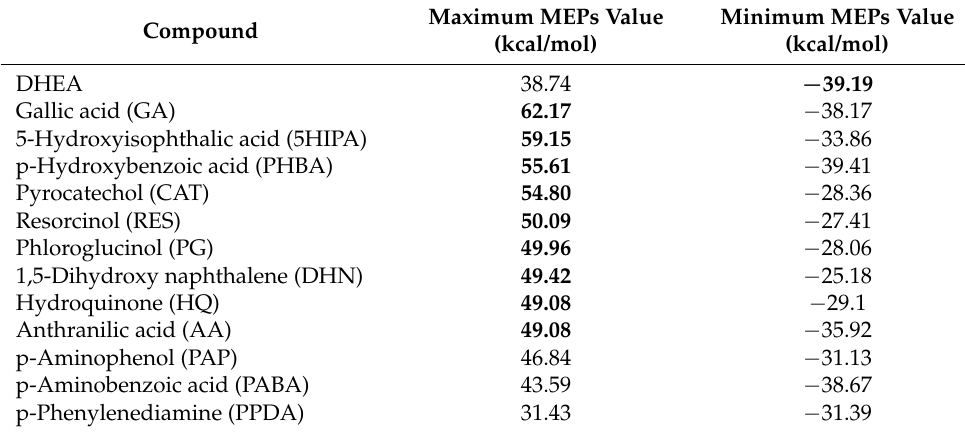
Figure 1. MEPs mapped onto 0.001 a.u. electron density isosurface of DHEA and twelve coformers. The electrostatic potential extreme points (kcal/mol) are represented in blue and red, and the value is marked in black. Table 1. Calculated extreme MEPs value of DHEA and twelve coformers.